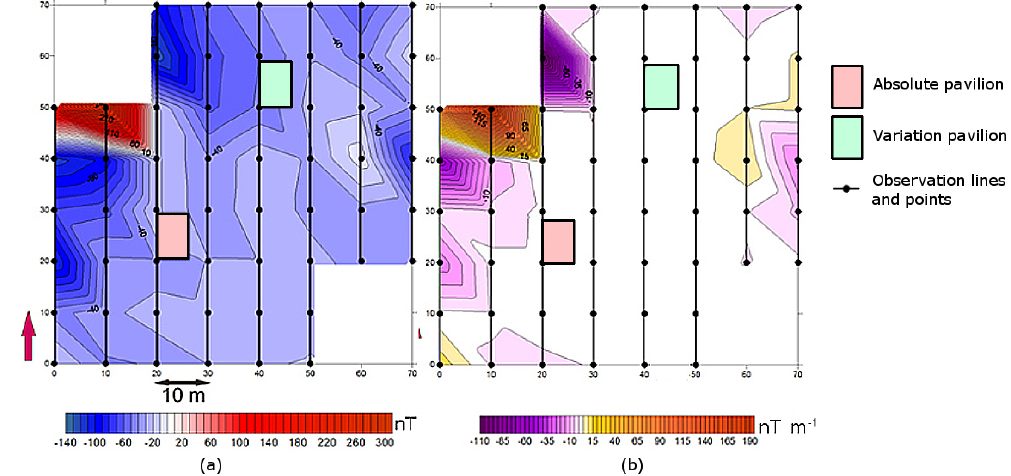
Figure 2. Maps of magnetic anomalies (a) and vertical magnetic gradient (b) on the observatory territory.